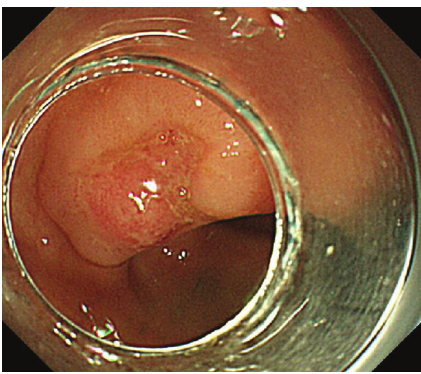
Figure 3: Ulcer bed after en-bloc resection of the lesion. There is no muscle damage or bleeding.